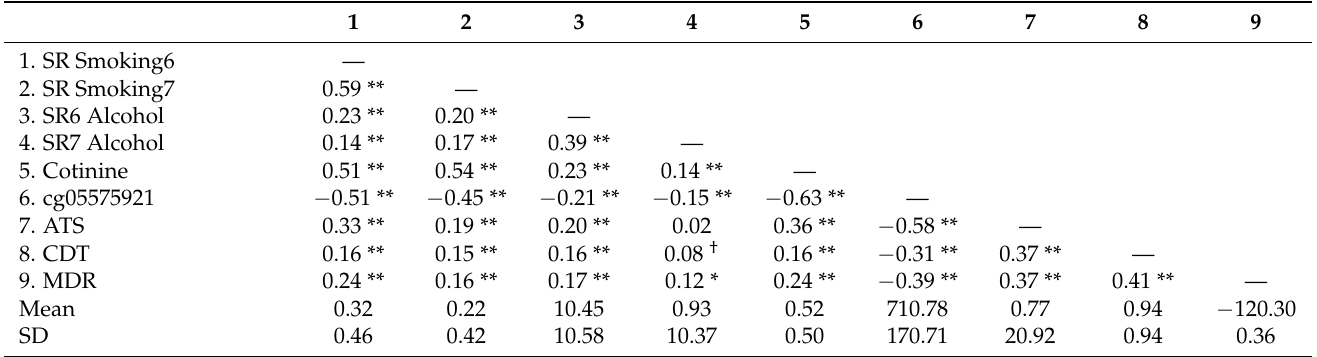
Table 3. Pearson correlation coefficients of each of the metrics for tobacco or alcohol consumption risk to themselves.